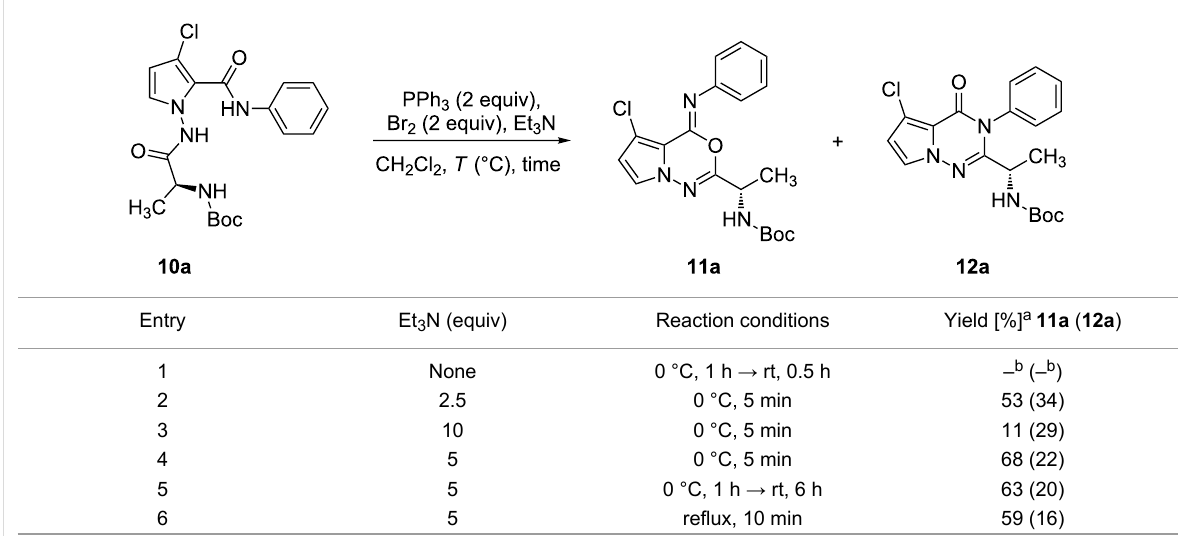
Table 1: The studies on various reaction conditions.